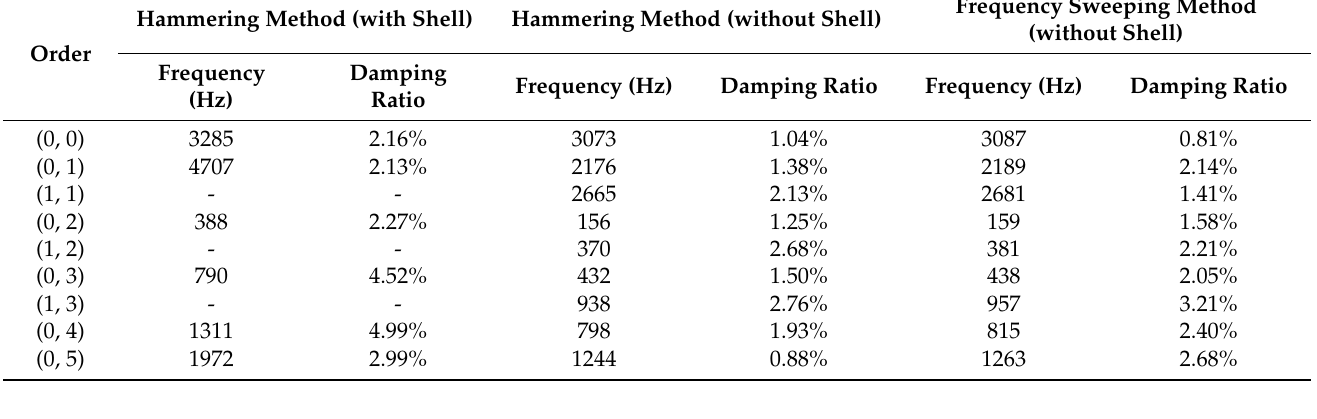
Table 1. Modal frequency and corresponding damping ratio for each order.